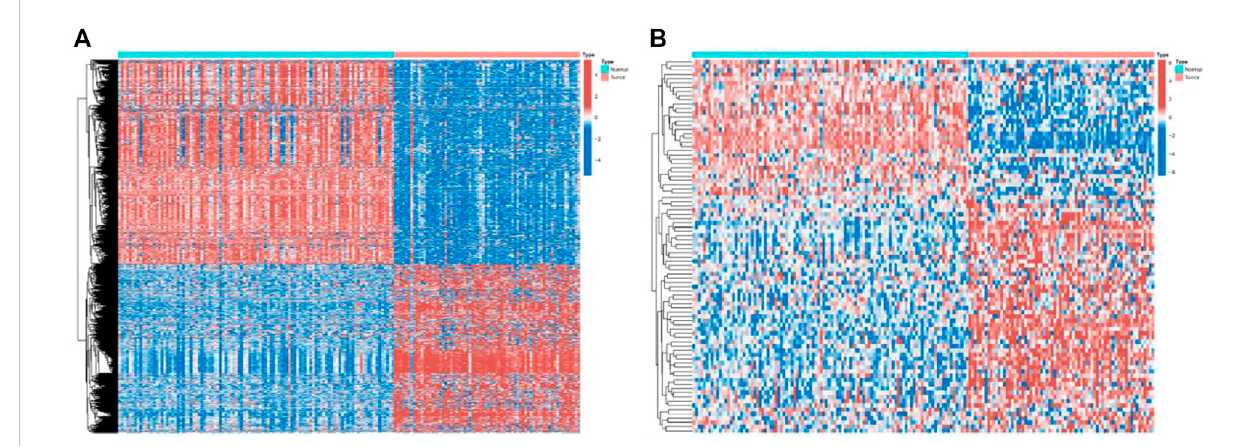
FIGURE 2 Expressions of the 1438 genes and 524 miRNAs. (A) Heatmap of the 1438 genes between the normal (N, blue) and the tumor tissues (T, red). (B) Heatmap of the 524 miRNAs between the normal (N, blue) and the tumor tissues (T, red).